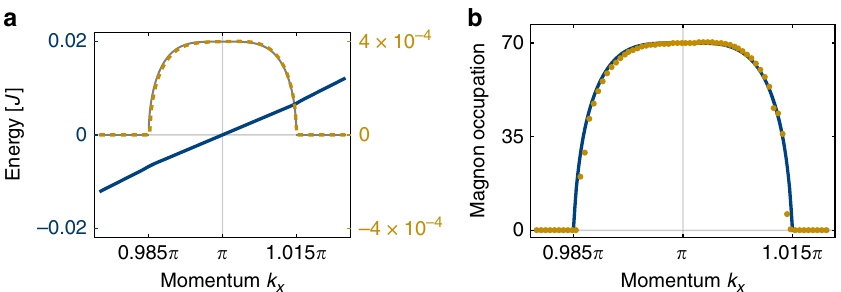
e Q π Þj ¼ 4 ´ 10 (cid:2) 4 J and E (cid:2) s (cid:2) s ð k 0 ¼ j E 0 jj